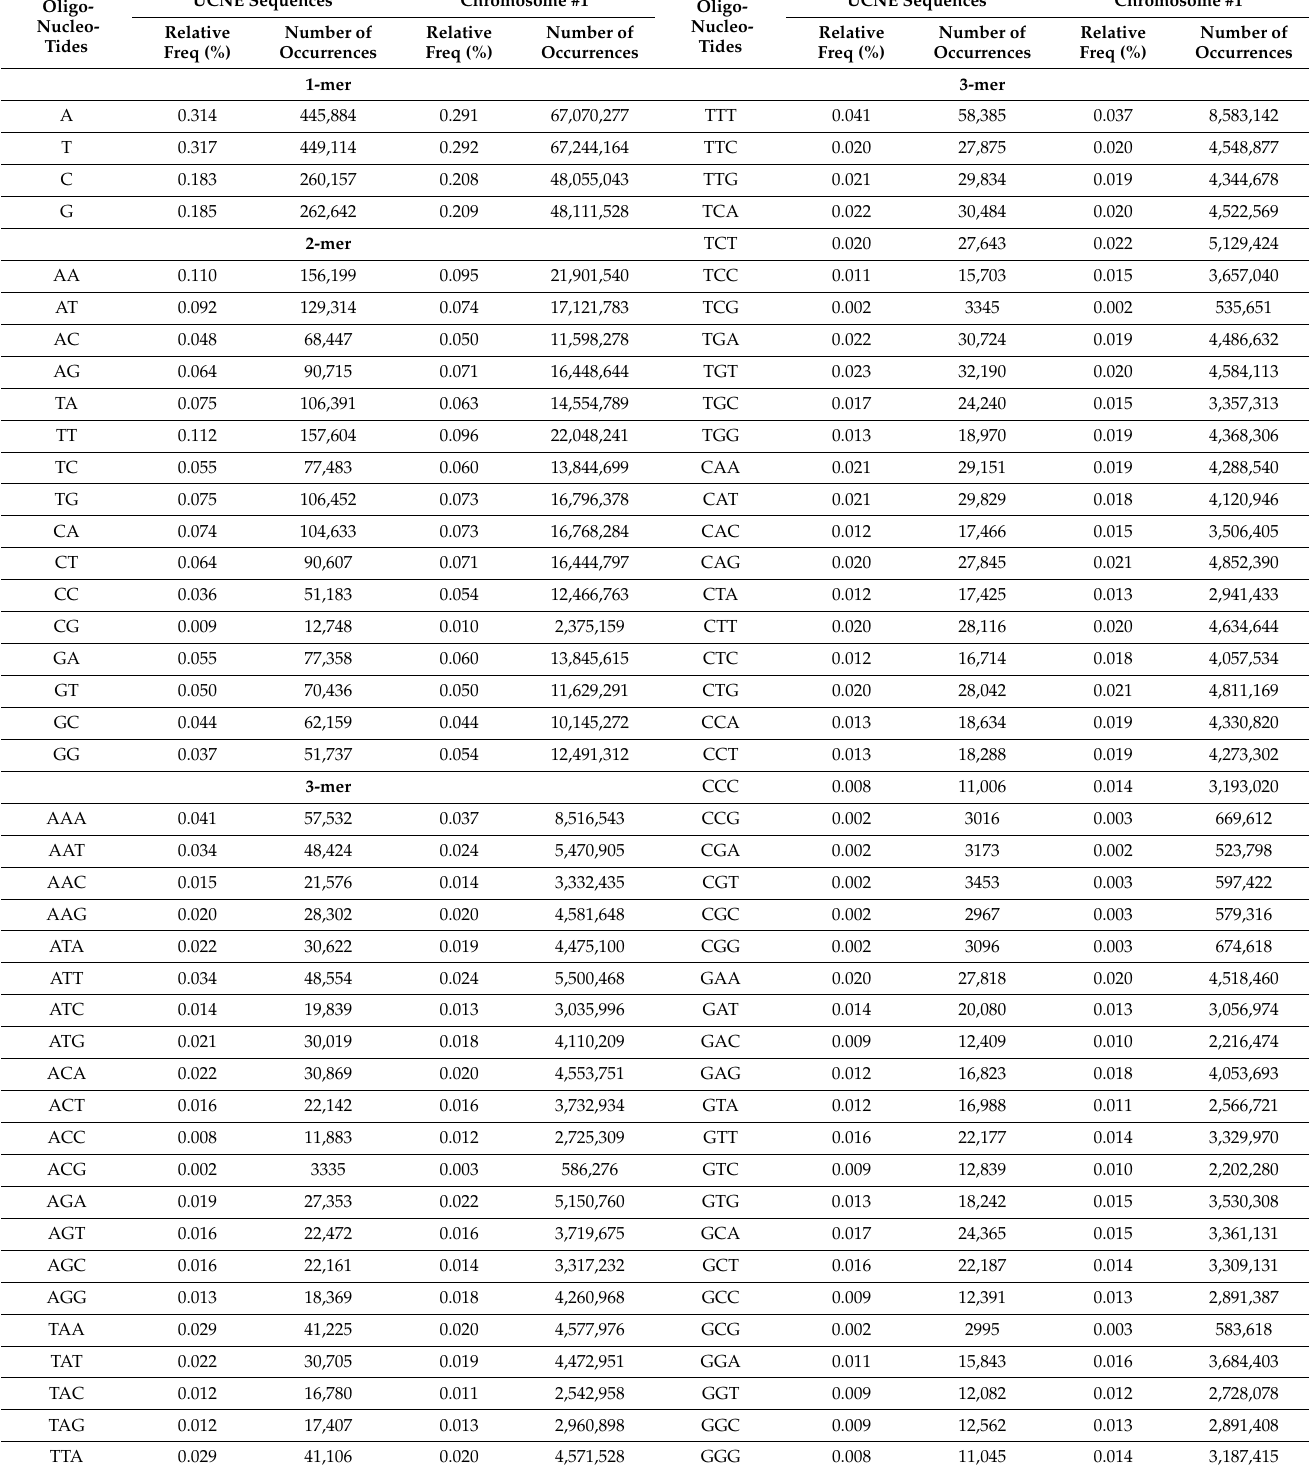
Table 3. Distribution of oligonucleotides inside 4273 UCNE sequences. The relative frequency of an n - mer oligonucleotide was calculated by dividing the number of occurrences of this oligonucleotide by the total number of occurrences of all n -mer oligonucleotides. The sum of all relative frequencies for all oligonucleotides of the same size is equal to 1. The entire distribution of 1 to 8-mer oligonucleotides for all human chromosomes and UCNEs is shown in the Supplementary File